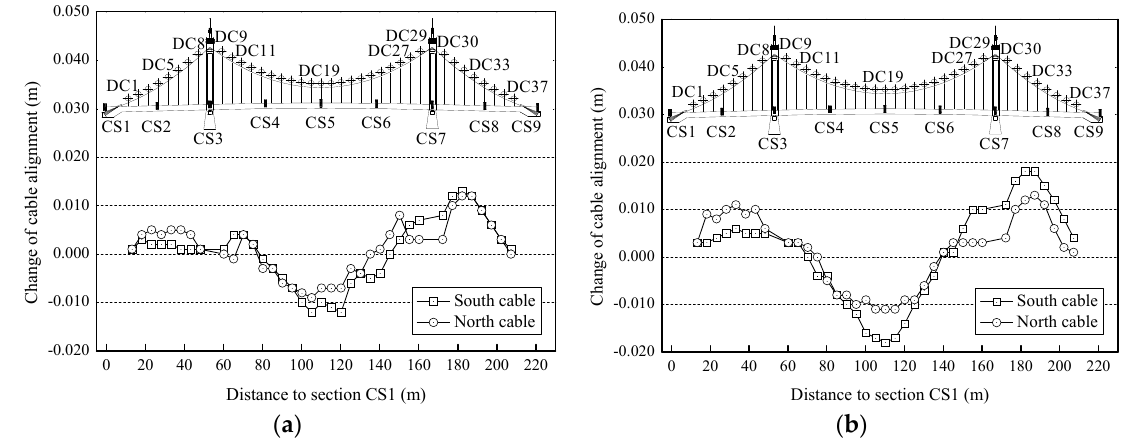
Figure 7. Measured changes of cable alignments during the one-year period from April 2015 to April 2016: ( a ) First half year period; and ( b ) One-year period.